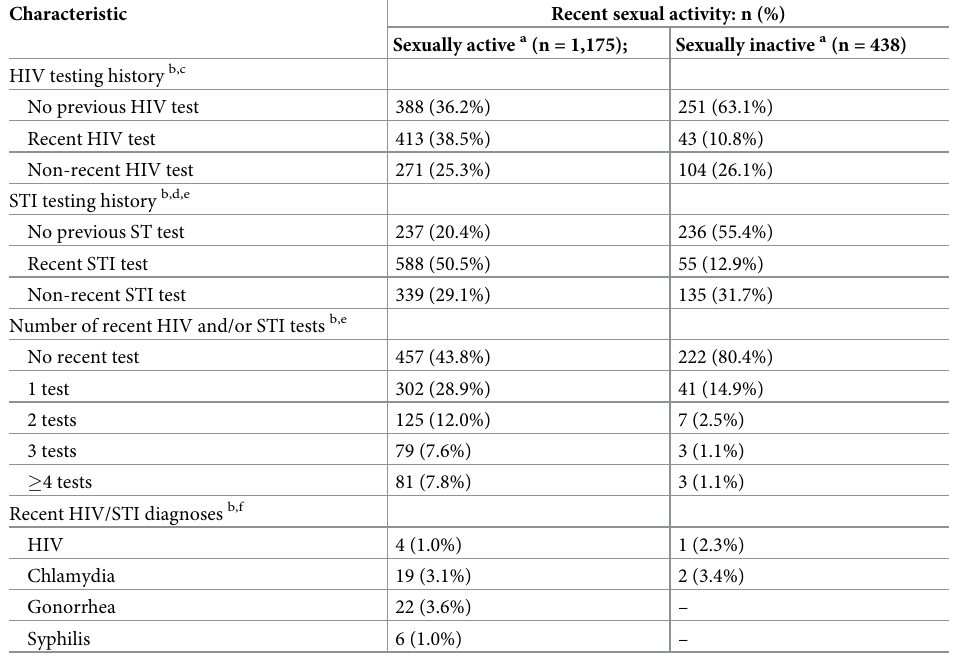
Table 3. HIV and STI testing characteristics among a sample of trans and gender diverse people in Australia (n = 1,613), stratified by sexual activity a